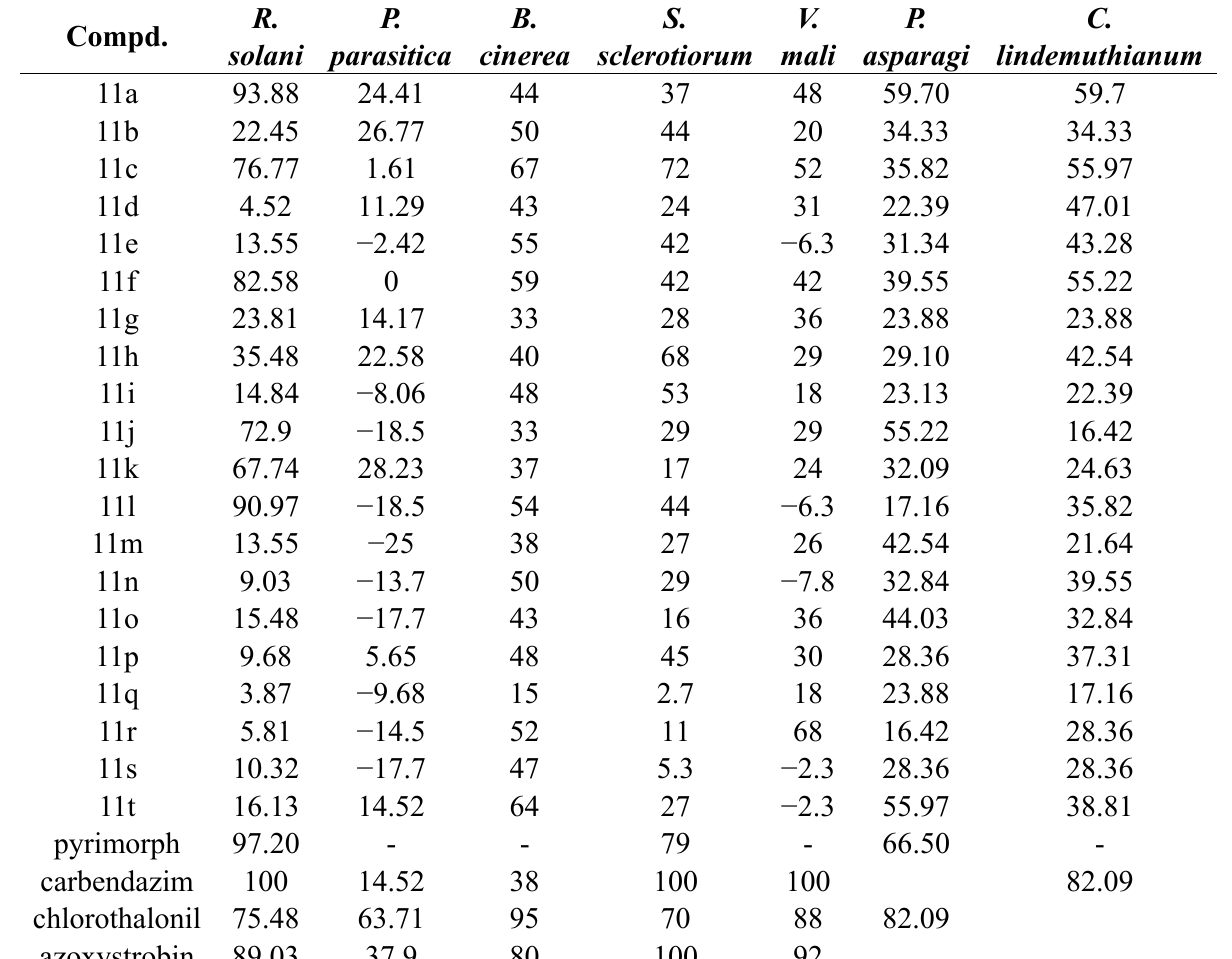
Table 2. Fungicidal activity of the title compounds (inhibition rate, %).